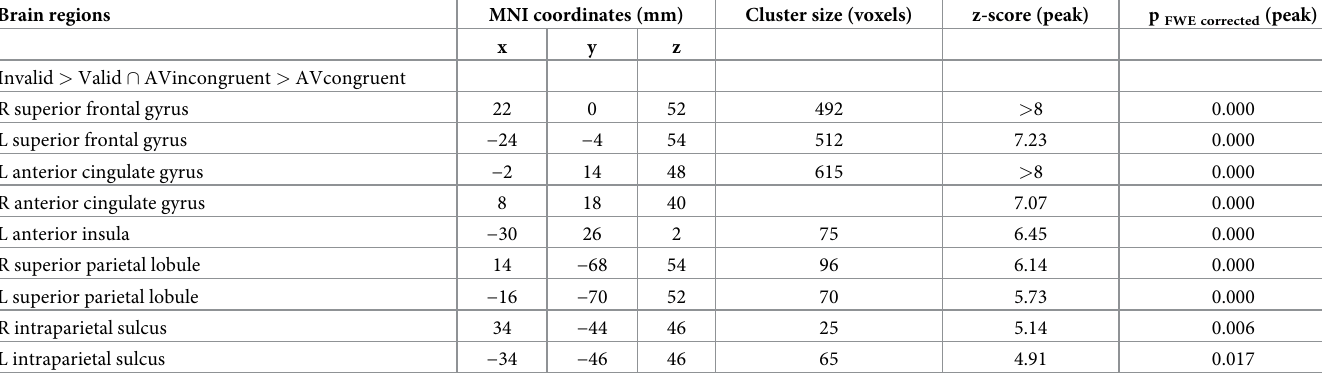
Table 1. fMRI univariate results: Conjunction of cue invalidity and audiovisual spatial incongruency. Brain